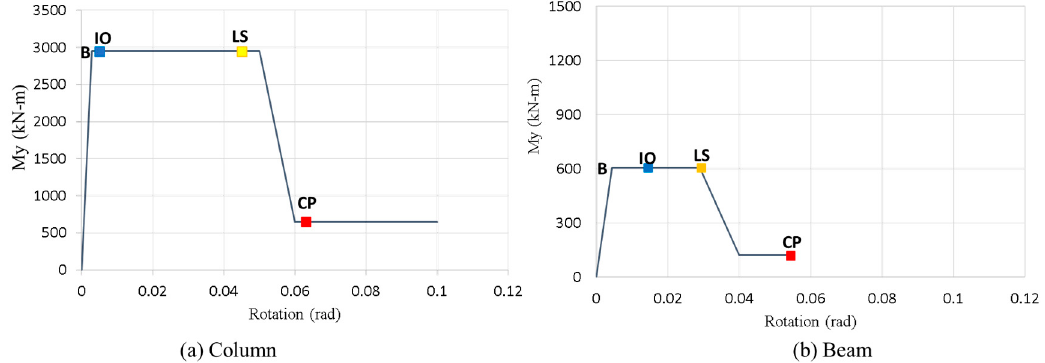
Figure 4. Moment–rotation relations of plastic hinges.